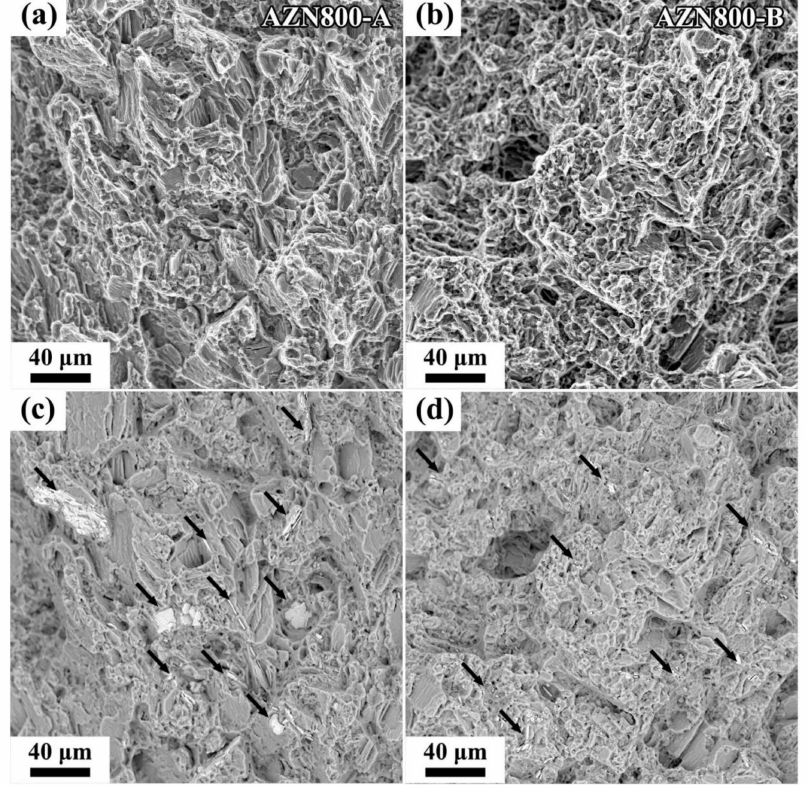
Figure 5. The tensile fracture topography of the ( a , c ) AZN800-A and ( b , d ) AZN800-B